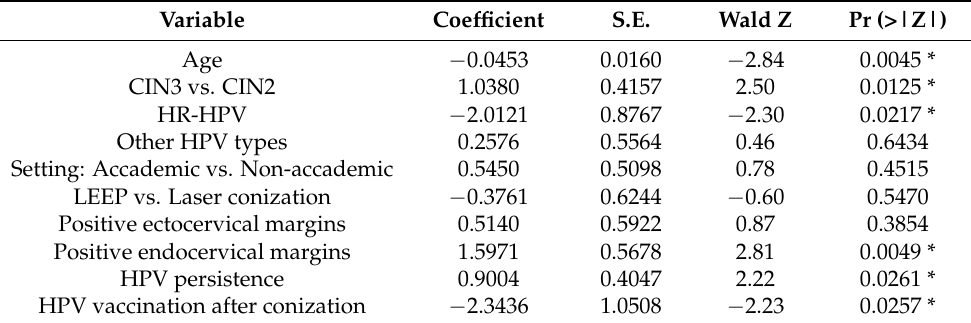
Table 2. Factors impacting the risk of cervical dysplasia persistence/recurrence.